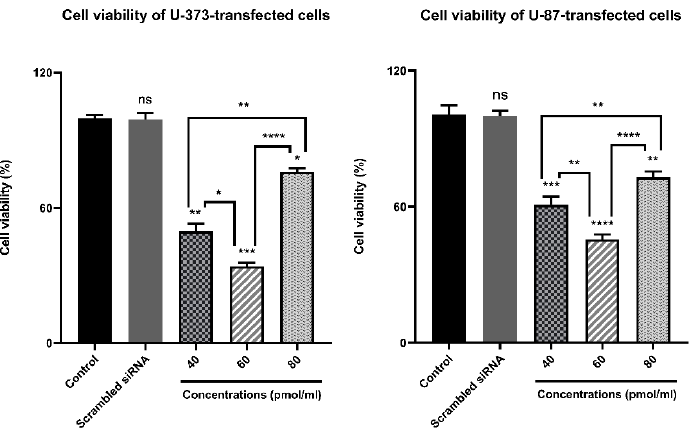
Figure 5. Bar graphs depicting ZEB2 suppression effect on the viability of glioma cells using an MTT kit developed by Sigma Aldrich. The results suggested that compared to control the transfection of U87 and U373 cells by different concentrations of ZEB2-siRNA (60–80 pmol/ µ L) after 48 from